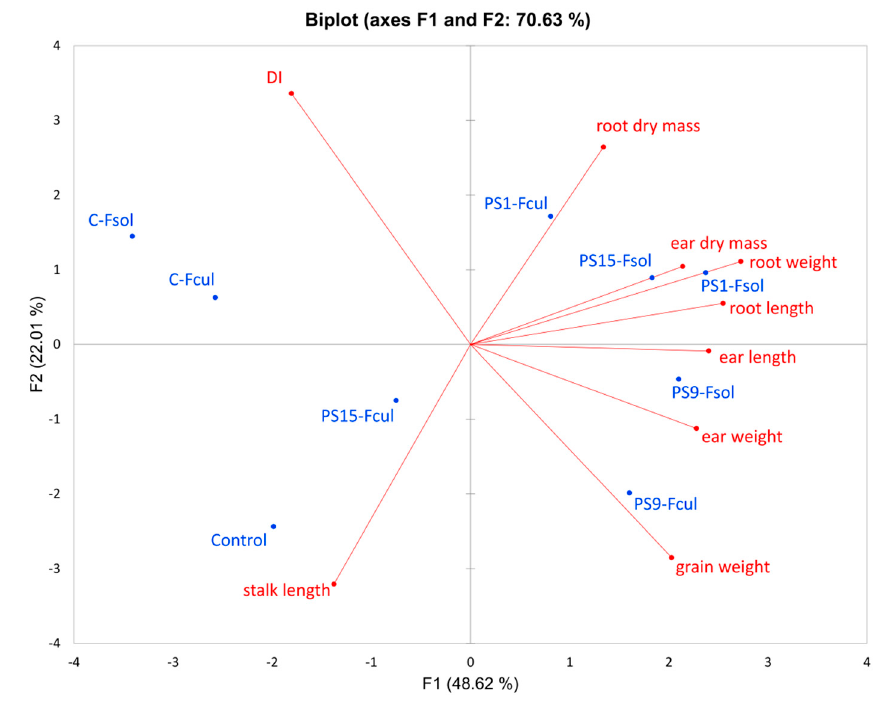
Figure 3. Principal component analysis (PCA) analysis of biometry and health parameters. Abbreviations: C—control; Fcul— F. culmorum ; Fsol— F. solani; PS1, PS9, PS15—tested PGPB strains; DI—Disease Index.